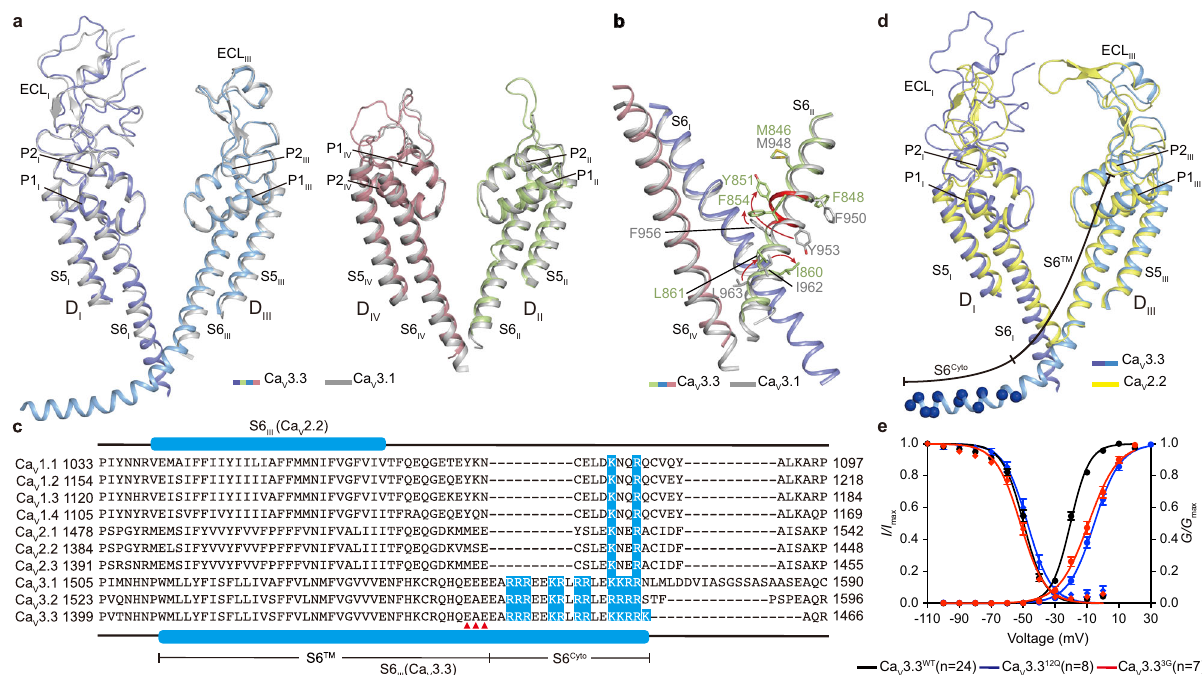
Fig. 2 Positive charged S6 Cyto region is critical for the channel gating. a The pore domain segments in the D I /D III (left panel) and D II /D IV (right panel) of the Ca V 3.3 (colored), superimposed with the corresponding region of Ca V 3.1 structure (gray). b Zoom-in view highlights the structural comparison S6 II helix between Ca V 3.3 apo and Ca V 3.1 (PDB ID: 6KZO) (gray). The shifts of the side chain of residue on S6 II helix between Ca V 3.3 apo and Ca V 3.1 undergoing axial rotation are indicated by red arrows. c Sequence alignment of S6 III helix of all human Ca V members, numbered according to full-length subunits. The secondary structure of Ca V 2.2 and Ca V 3.3 marked above and below the sequence alignment, respectively. The dashes represent gaps. The positively charged residues on S6 III are shaded in blue. Residues involved in Ca V 3.3 3G are marked by red triangle. d The pore domain segments in the D I /D III of the Ca V 3.3 apo (colorful) and Ca V 2.2 (PDB ID: 7VFS) (yellow) are superimposed. The S6 Cyto and S6 TM regions are indicated. The positively charged residues on the S6 Cyto region are shown as blue spheres. e. Normalized conductance-voltage (G/V) and current-voltage(I/V) relationship for the Ca V 3.3 WT construct (black) and mutant Ca V 3.3 12Q (blue), triple-mutant Ca V 3.3 3G (red). n represents the number of repeated measurements. N cells were analyzed (WT, n = 24; Ca 12Q , n = 8; Ca 3G , n = 7). Data are presented as mean values ± SEM. Source data are provided as a Source Data fi V 3.3 V 3.3